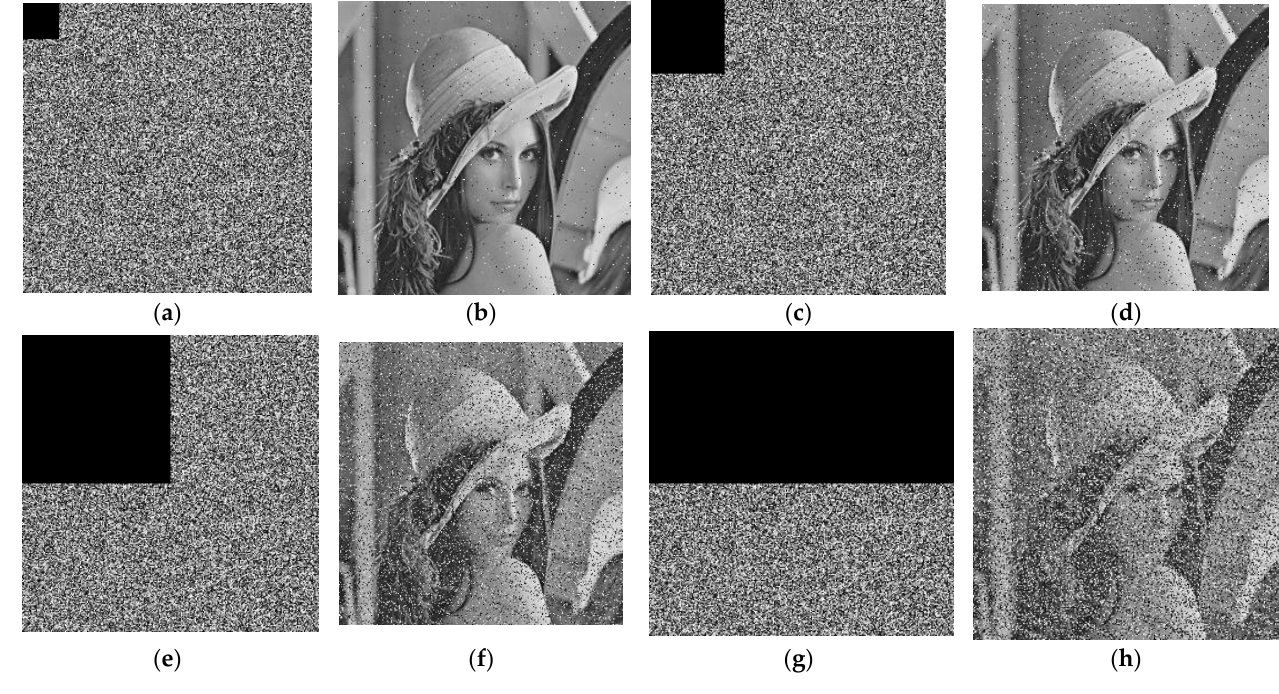
Figure 10. Data loss attack test. ( a ) 1/16 cropped; ( b ) corresponding decrypted image of ( a ); ( c ) 1/8 cropped; ( d ) corresponding decrypted image of ( c ); ( e ) 1/4 cropped; ( f ) corresponding decrypted image of ( e ); ( g ) 1/2 cropped; and ( h ) corresponding decrypted image of ( g ). Table 7. PSNR and MES testing results subject to data loss attacks.